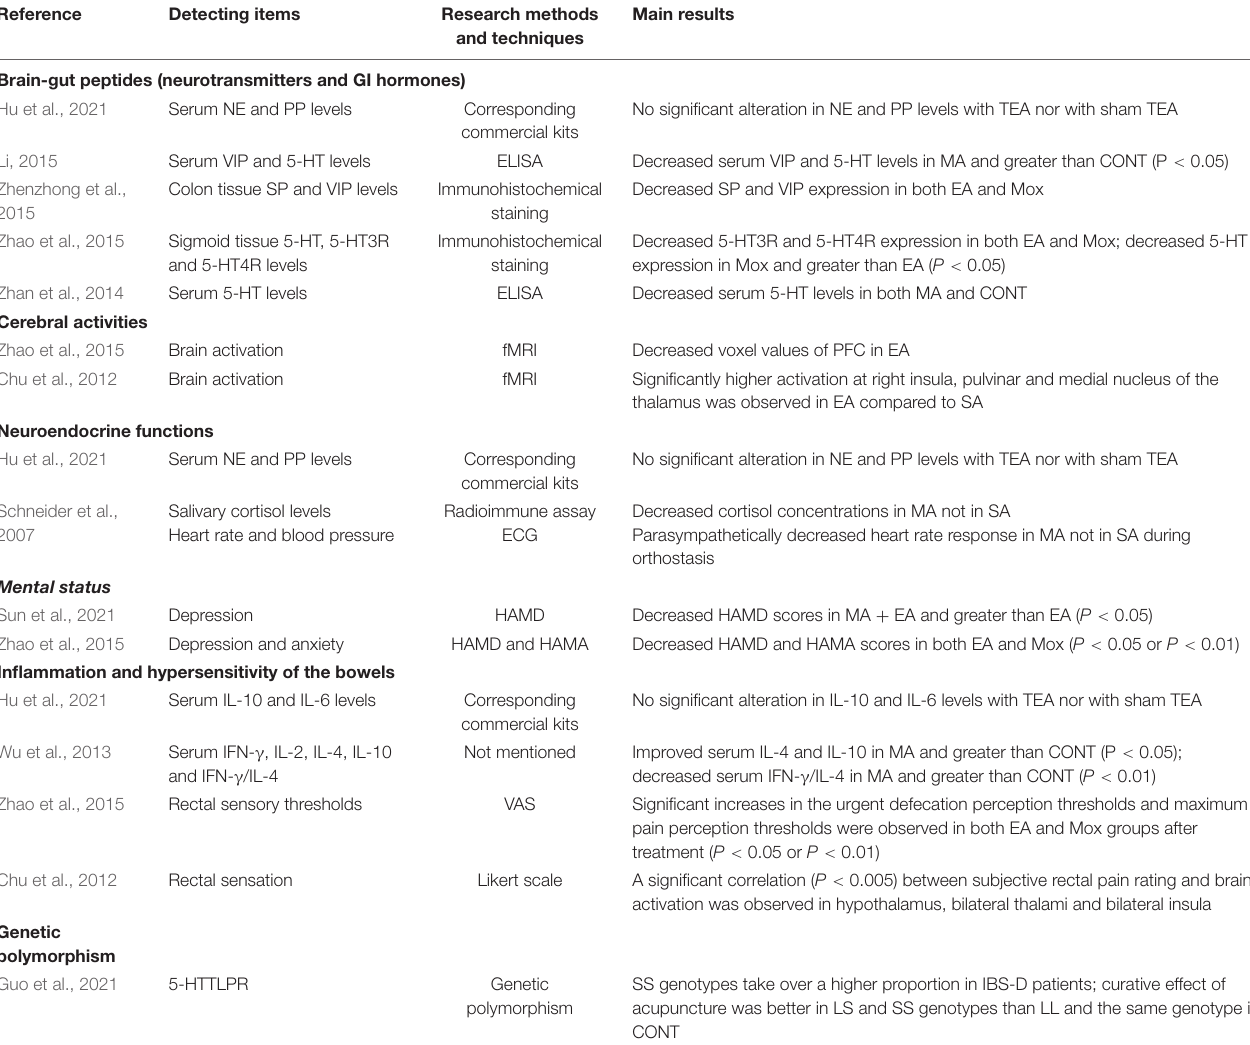
TABLE 2 | Mechanism research of included